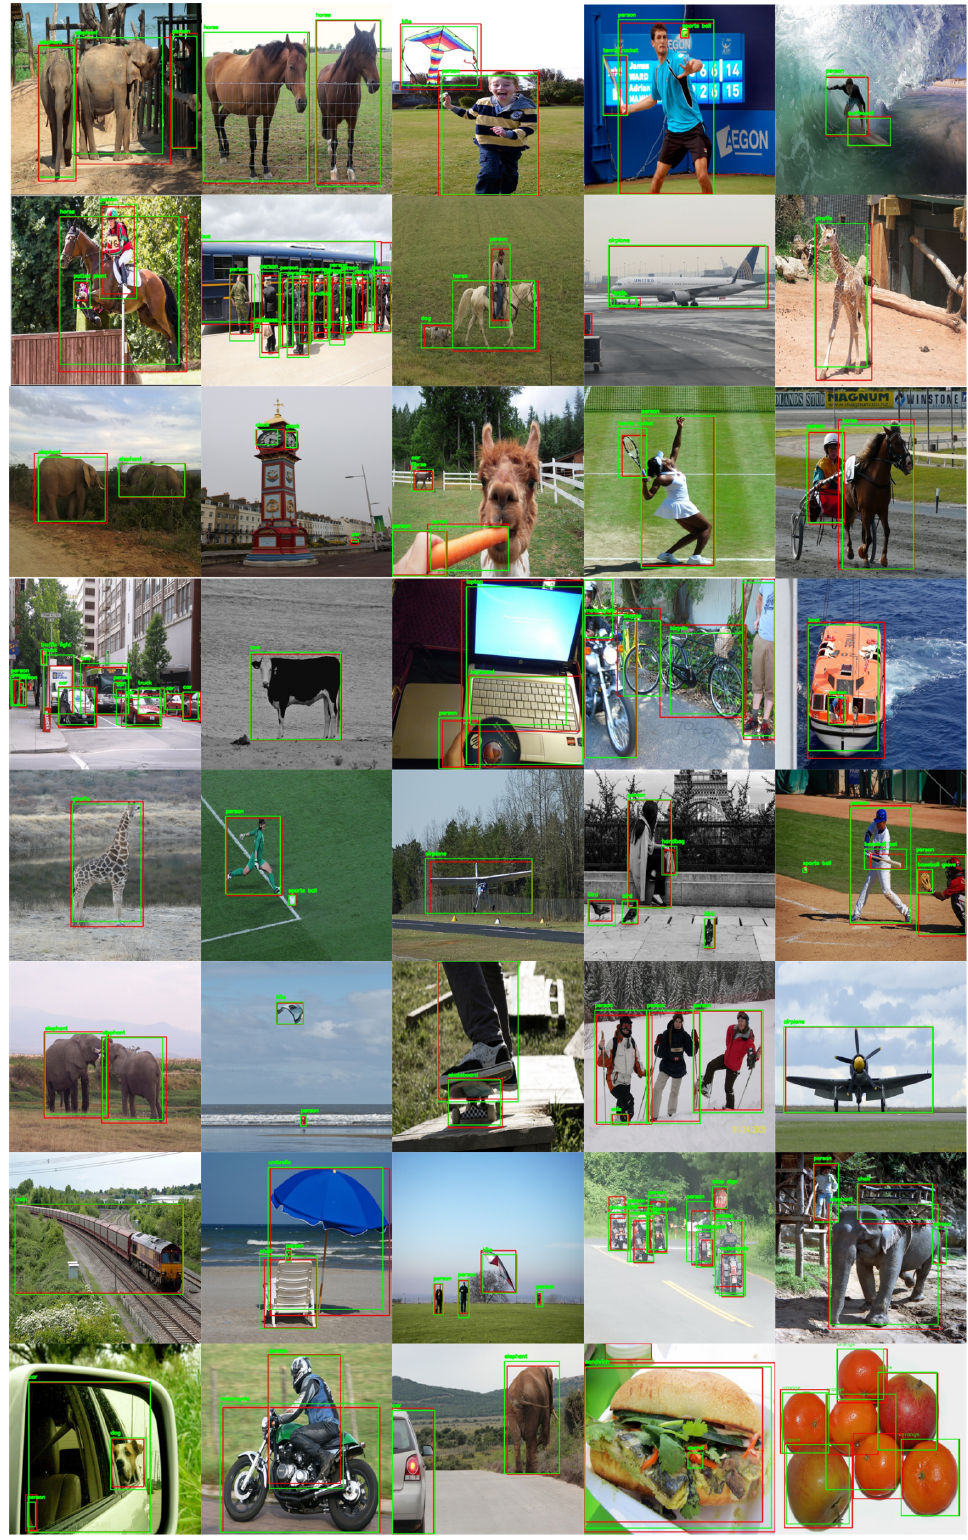
Figure 10. Sample results were obtained by the proposed method on random images from MS-COCO minival dataset. The green and red boxes refer to the detected and ground truth boxes,